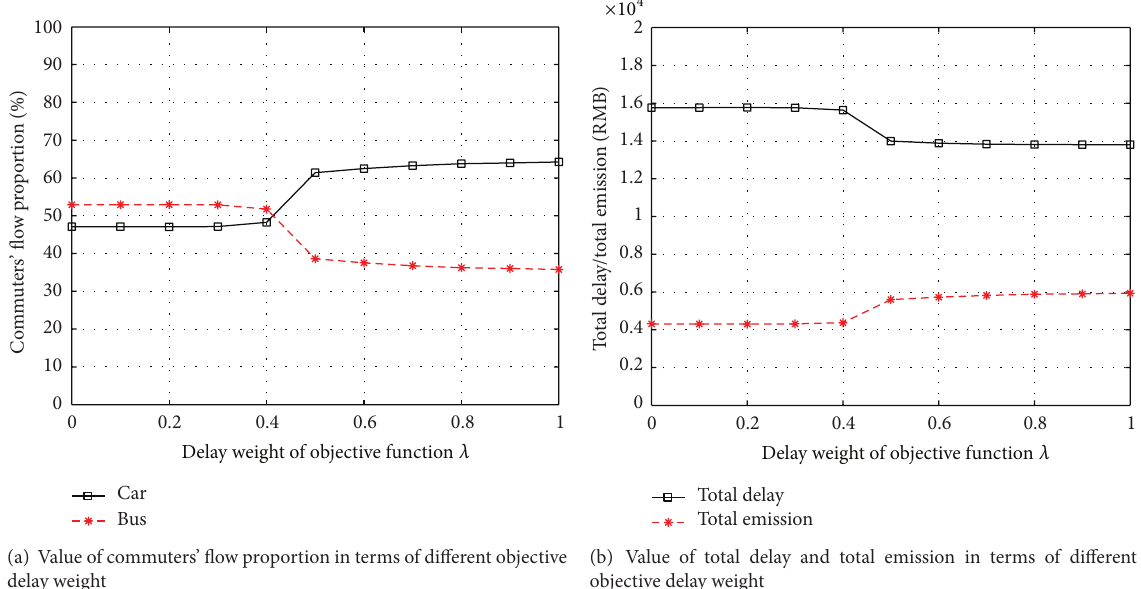
Figure 3: Sensitivity analysis of objective delay weight